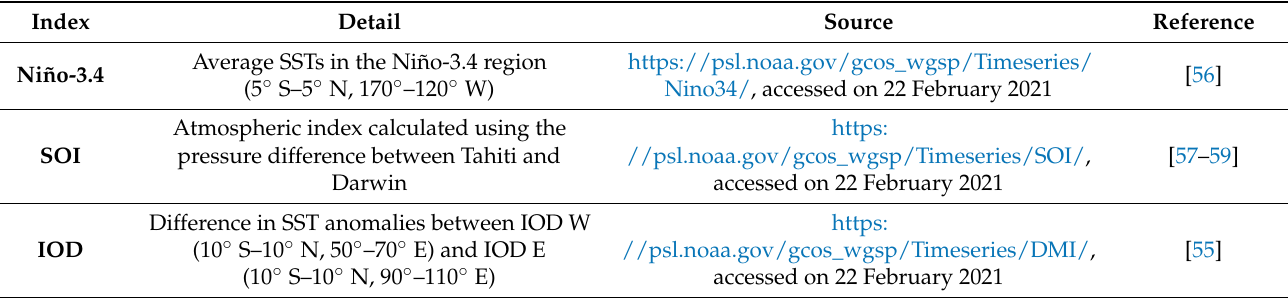
Table 1. Indices used for measuring drought driving